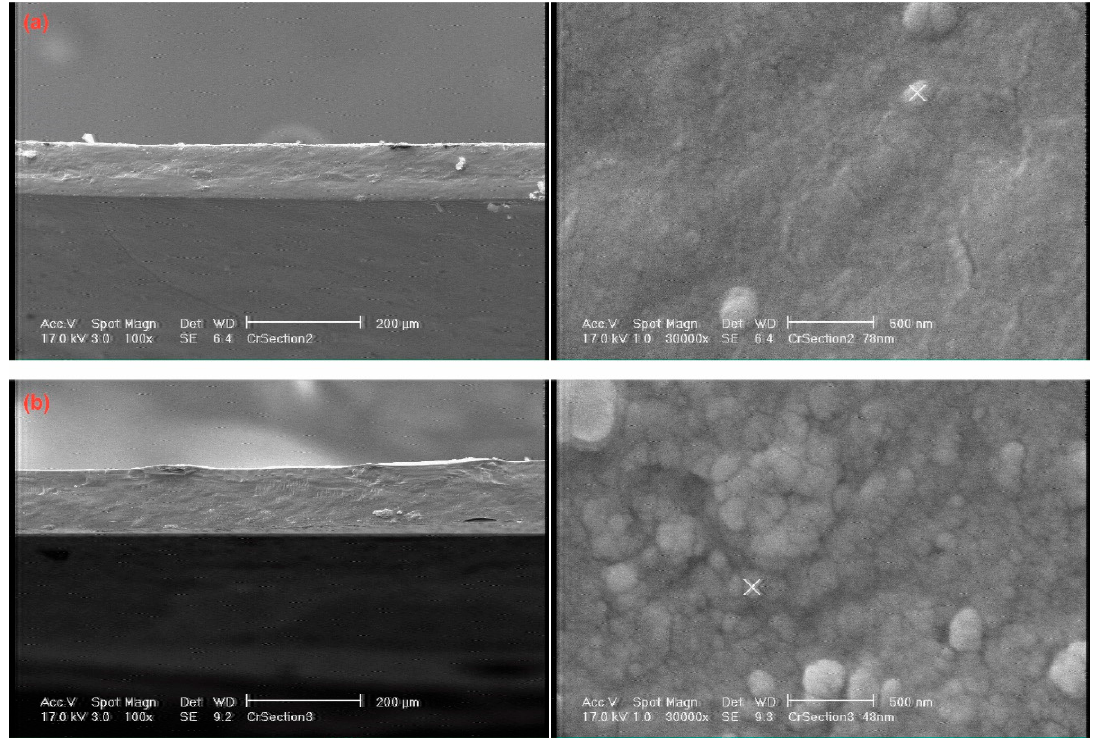
Figure 5. SEM images of ( a ) PU/PVA200–40-S5 and ( b ) PU/PVA200–40-S20.